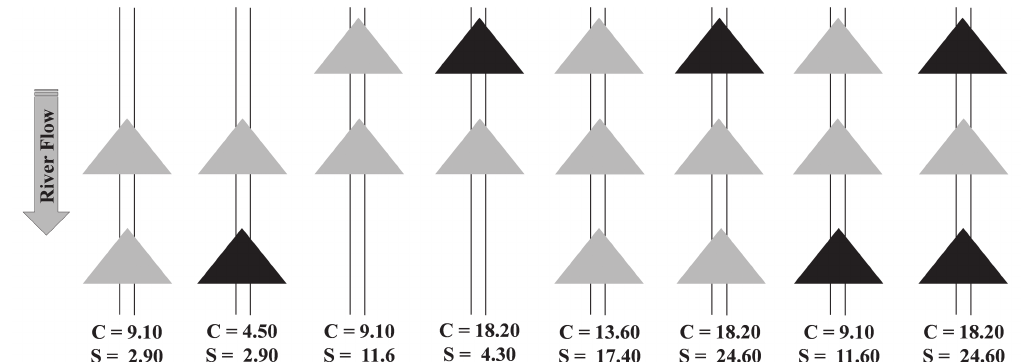
Fig. 3. Connectivity of the studied dam (middle triangle) with upstream and downstream reaches, mediated by the presence/ absence of other dams (other triangles) and fish passage facilities (black = passage absent; grey = passage present). The figure shows the percentage of each connectivity scenario (C) and studies